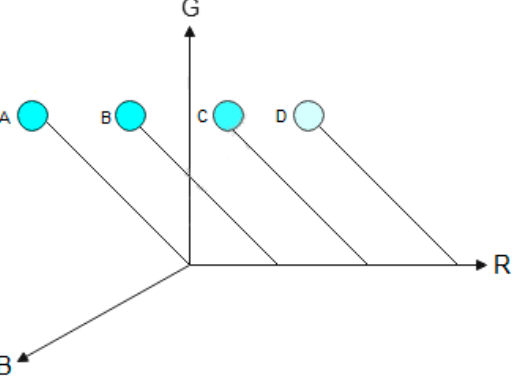
Figure 9. Behavior of the cyan color as a function of the red channel. A (0, 255, 255). B (75, 255, 255). C (150, 255, 255). D (225, 255, 255). For (R, G, B)